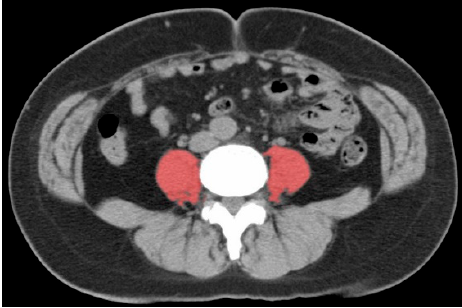
Figure 2. Image of the total bilateral psoas muscle area at the L3 level. The red area is measured as the psoas region.